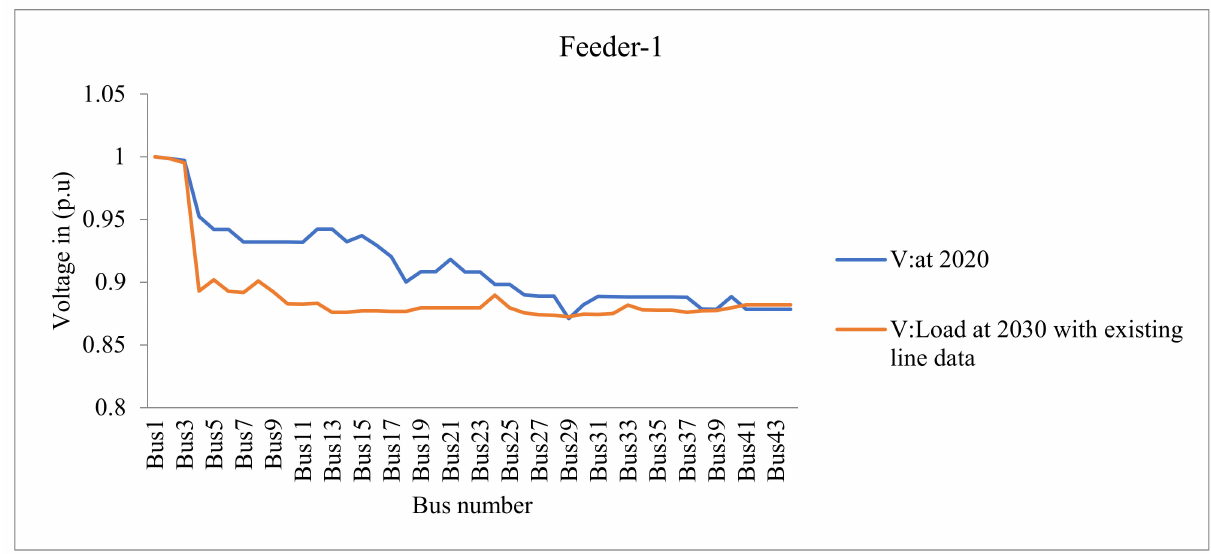
Figure 5. Existing Addis North feeder-1 network voltage profiles on existing and forecasted